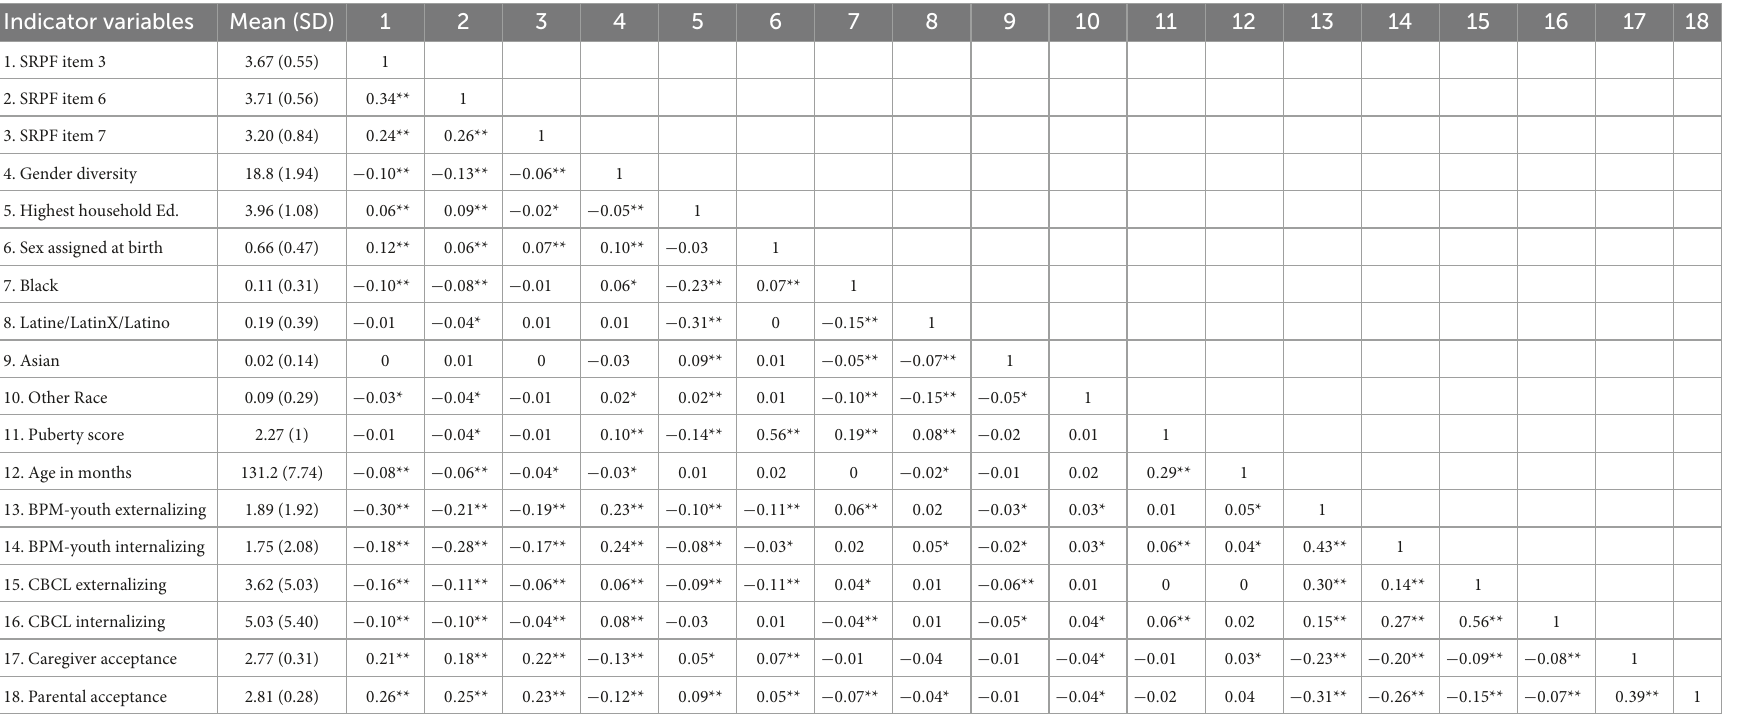
TABLE 5 Bivariate correlations and descriptive statistics for aim